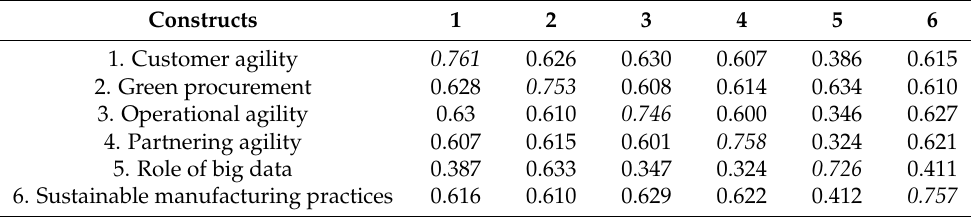
Table 2. Discriminant Validity Analysis (Fornell Larcker and HTMT).